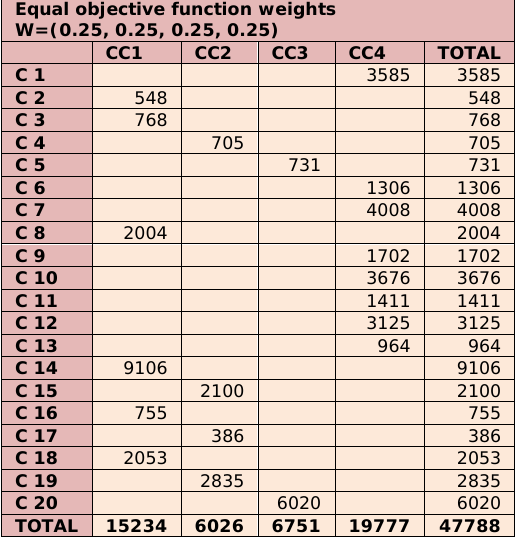
Table 5. Flows between customers and collection centers. Equal objective function